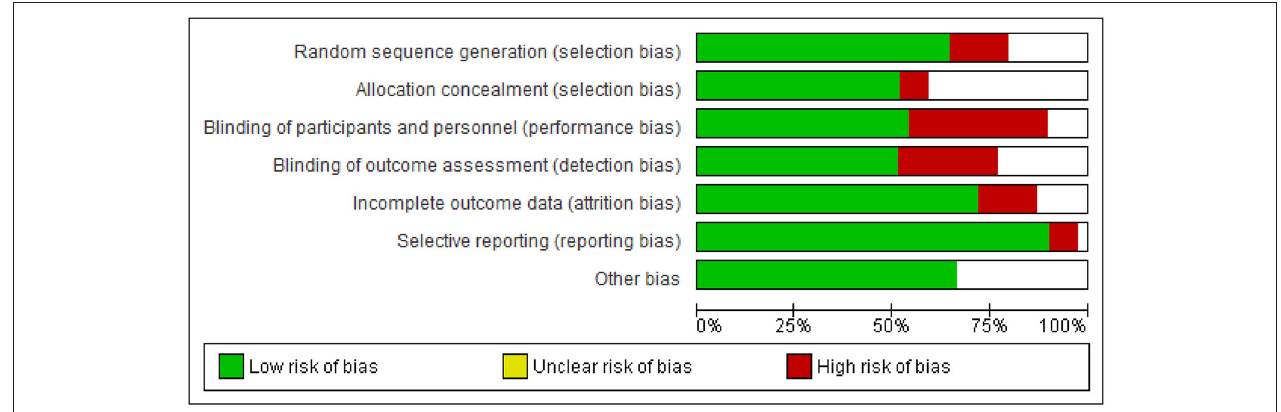
FIGURE 2 | Methodological quality graph: review authors’ judgements about each methodological quality item presented as percentages across all included studies.